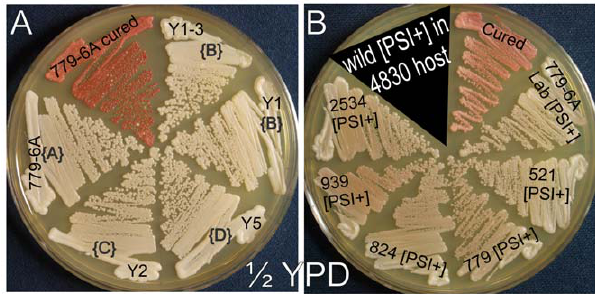
Figure 1. [ PSI + ] variants with distinct transmission properties can have identical ‘‘strong’’ or ‘‘weak’’ phenotypes. A. [ PSI + ] strains derived from 779-6A by extensive non-selective subcloning have different transmission patterns, but identical ‘‘strong’’ phenotypes. B. [ PSI + ] prions in wild S. cerevisiae isolates were moved into strain 4830 for direct comparison of prion intensity. Each is ‘‘weak’’, although transmission to Sup35p polymorphs varies as indicated. [A], [B], [C] and [D] refer to the transmission types shown in Table 5.